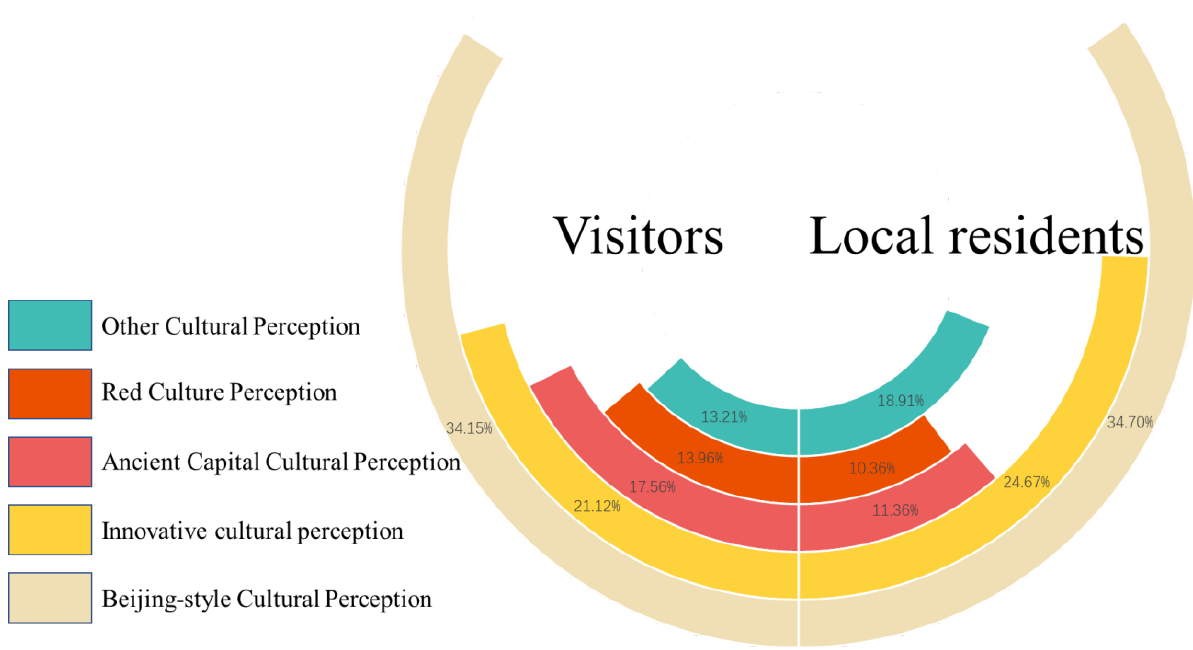
Figure 7. Percentage of cultural perceptions of users with different attributes.